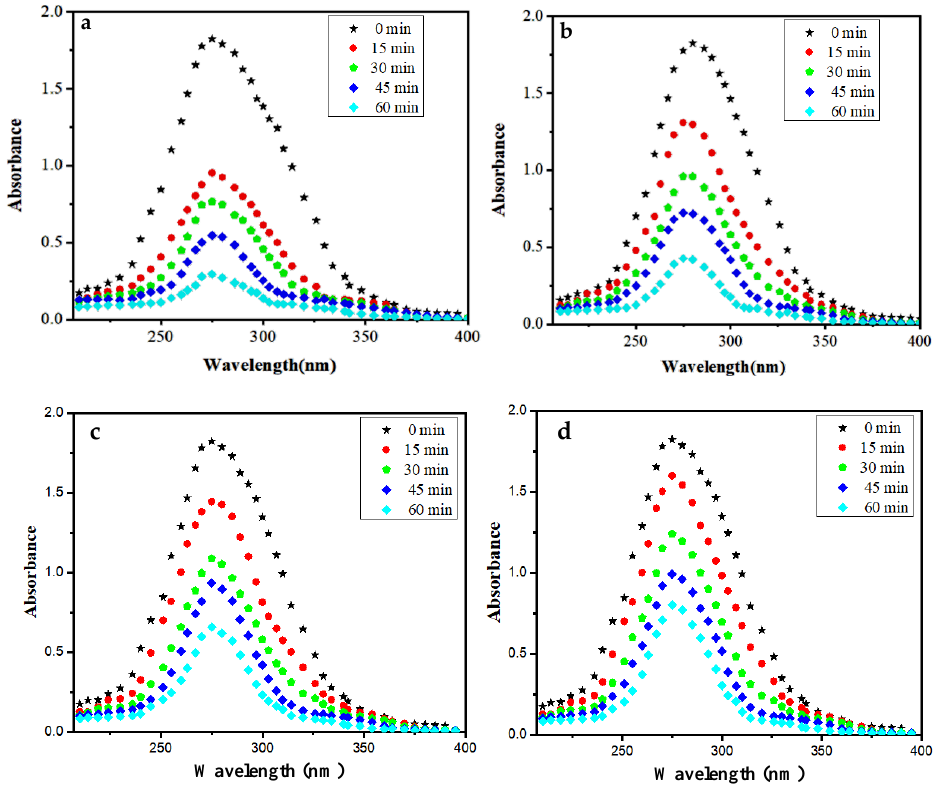
Figure 10. Absorption spectra of NOFX (15 mg / L) under optimal conditions (25 mL of SDB, pH 10, 60 min, 60 mgs QDs in the presence of ( a ) Mn:ZnS QDs in UV light; ( b ) Pure ZnS QDs in UV light ( c ) Mn:ZnS QDs in sunlight ( d ) Pure ZnS QDs in